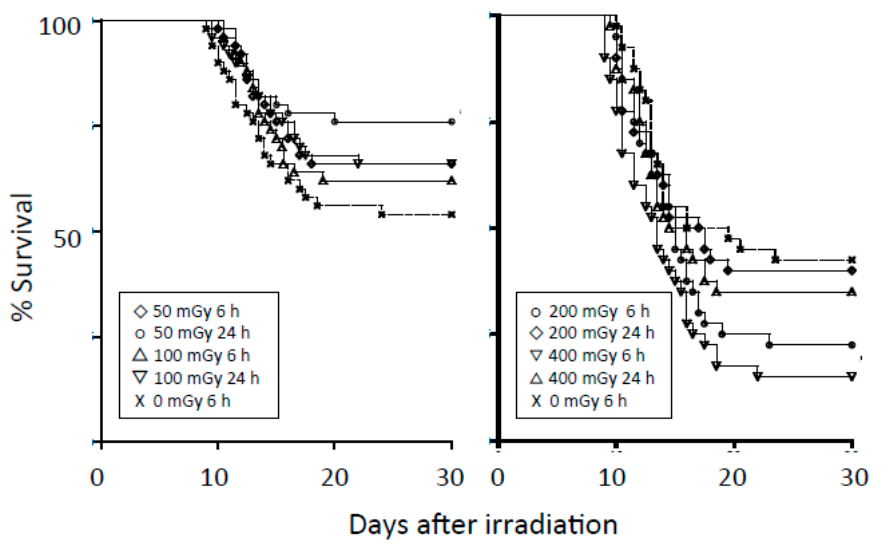
Figure 1. Left panel: Survival curves for C57BL/6 male mice after conditioning irradiation at 0, 50, or 100 mGy and challenge irradiation at 5.9 Gy given 6 or 24 h later. Each group consisted of 50 mice. The group receiving 50 mGy 24 h before the challenge dose had higher survival rates than the control group ( p = 0.021). Right panel: Survival curves for C57BL/6 male mice after a conditioning dose of 0, 200, or 400 mGy and challenge dose of 5.9 Gy given 6 or 24 h later. Each group consisted of 40 mice. The group receiving 400 mGy 6 h before the challenge dose had lower survival rates than the control group ( p = 0.0032). Modified from Reference [29].